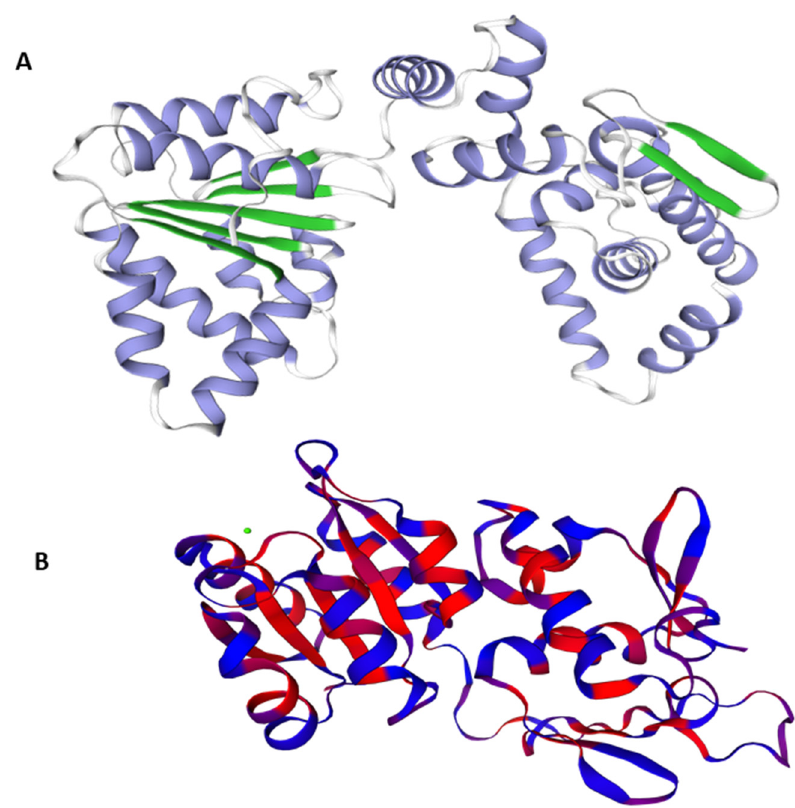
Figure 1. 3D structures of the target proteins DNaA ( A ) and TCR ( B ).